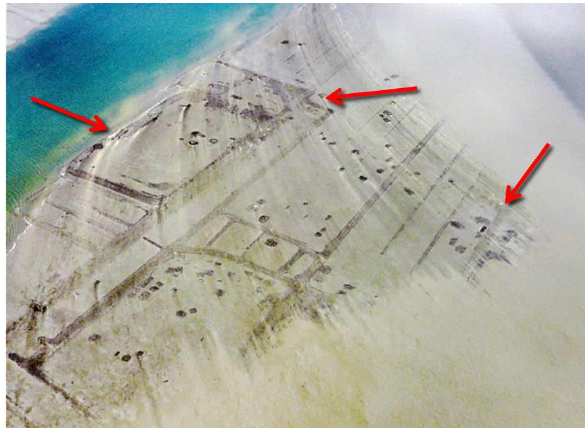
Figure 7. Aerial photograph of exposed intertidal flats north of Pellworm, taken in July 2009. Residuals of former settlements, close to a tidal creek (upper left), can be clearly seen. The arrows were included for easier comparison with the SAR image shown in Figure 6. Photograph: B. Hälterlein, LKN.